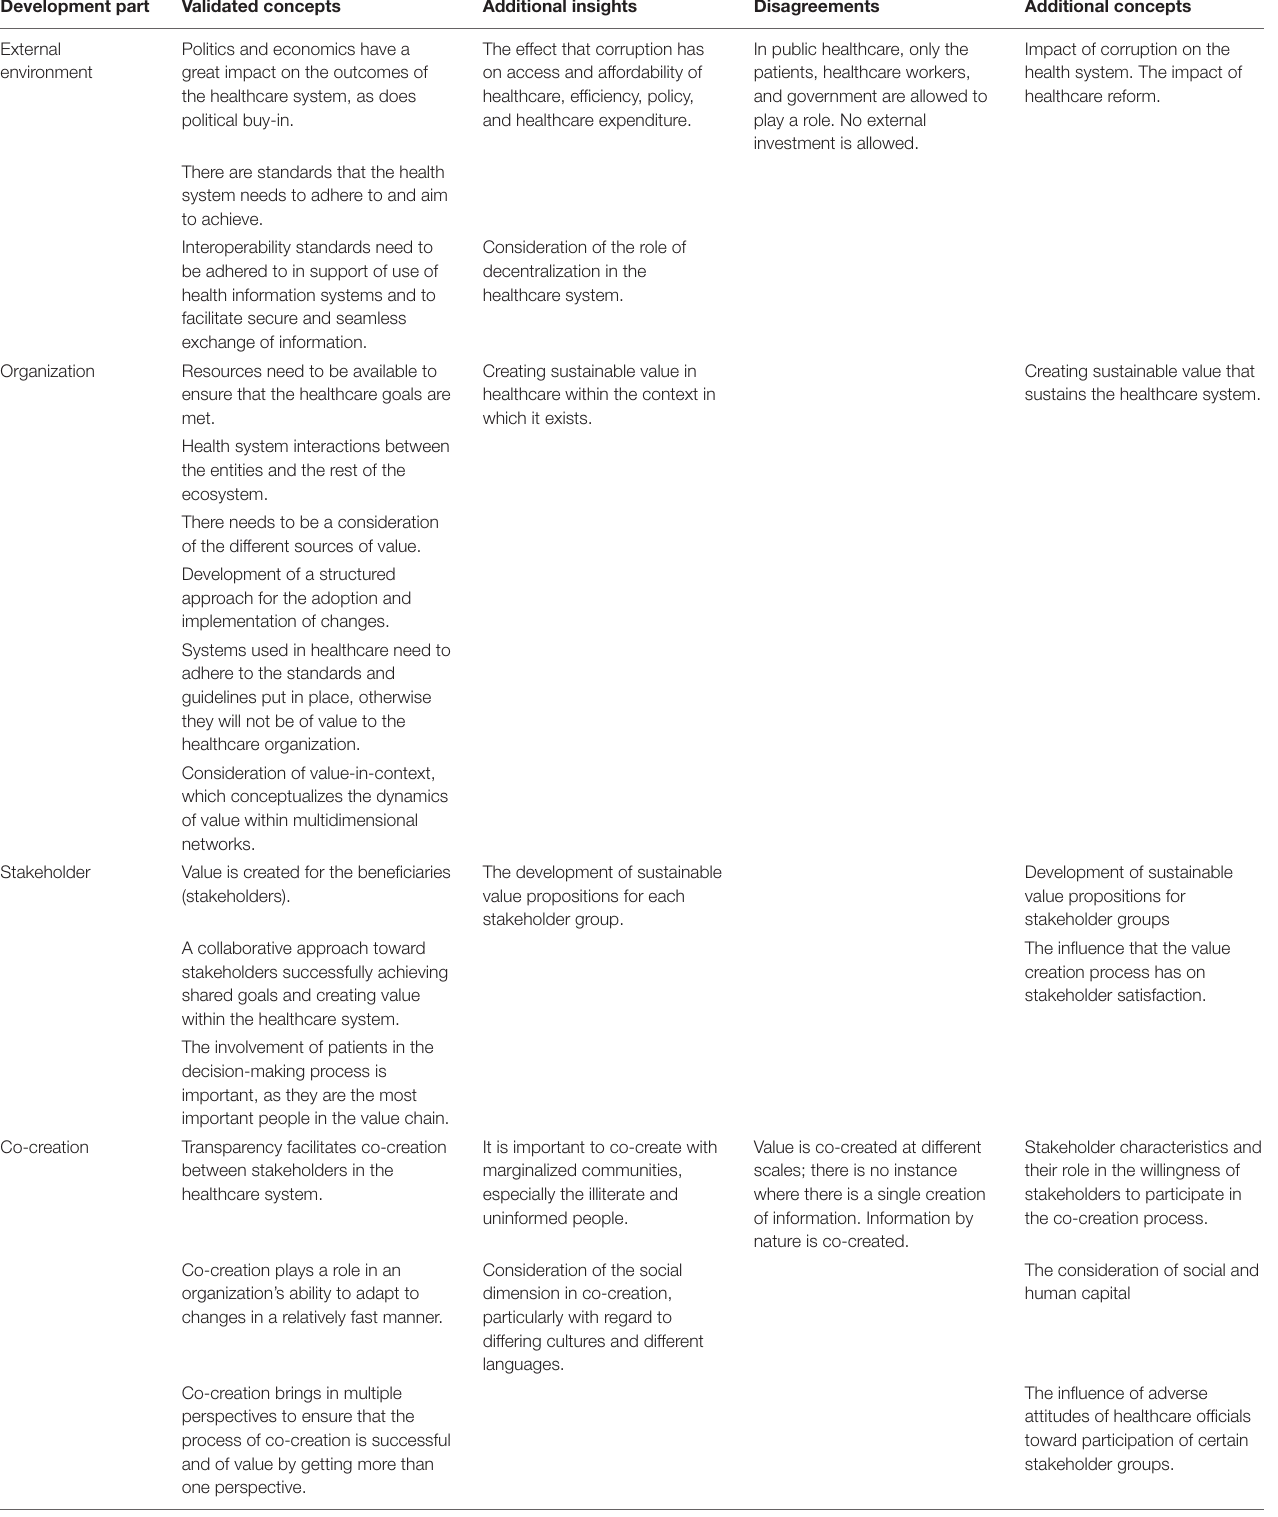
TABLE 3 | Results of the semi-structured